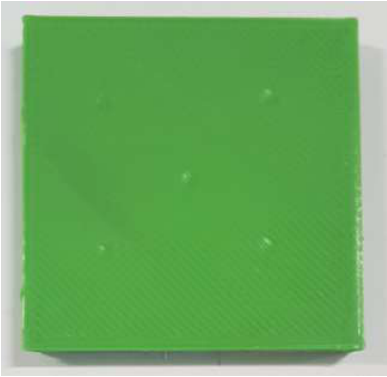
Figure 16. SEM micrographs for Al-ASA material: ( a ) control Al-ASA; ( b ) annealed at 70 °C; ( c ) annealed at 80 °C; ( d ) annealed at 90